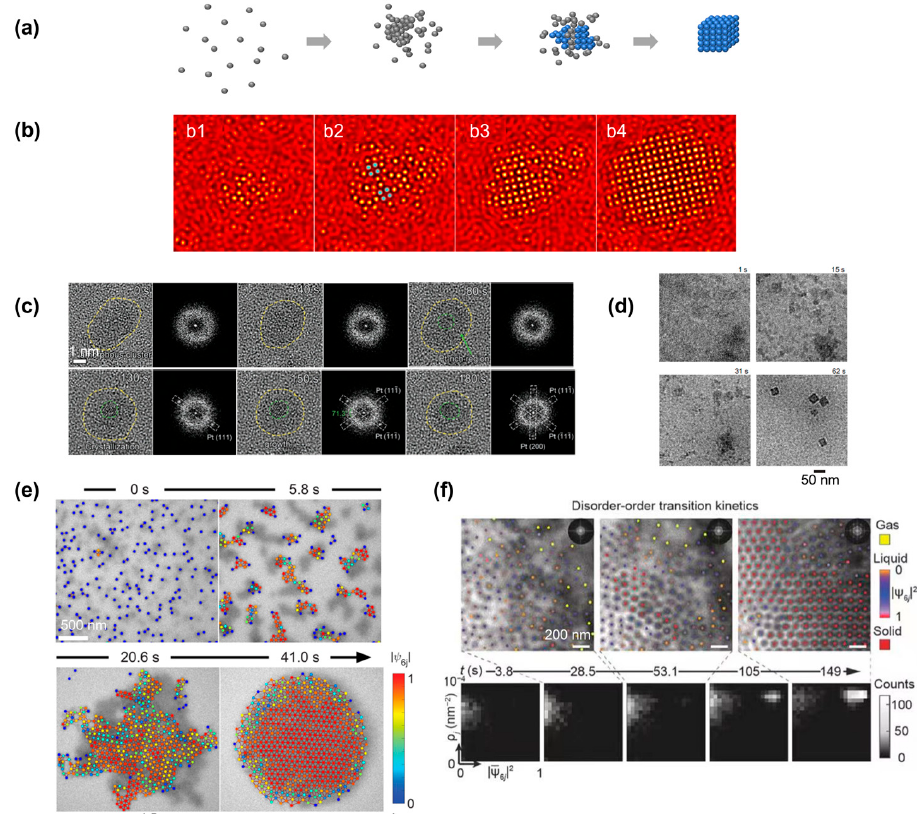
Figure 4. Simulation and experimental observations of the nonclassical crystallization pathway in which the crystalline domain nucleated from a large amorphous precursor: ( a ) Schematics illustrating the nonclassical crystallization pathway and highlighting the formation of an amorphous precursor first, from which the crystalline domain nucleated. ( b ) Simulation snapshots illustrating the formation of a large amorphous precursor first, and the crystalline domain (highlighted in blue) nucleated from inside of the cluster. From ( b1 ) to ( b4 ), the temporal evolution of a single nucleus is shown in computer simulation. Reproduced with permission from Ref. [35]. Copyright 2016 American Chemical Society. ( c ) Liquid-phase TEM observations of the structural evolution of a large amorphous cluster of Pt and the transformation to a crystalline structure. Fast Fourier transformations are also included to highlight the structure transition. Reproduced with permission from Ref. [65]. Copyright 2022 Wiley Materials. ( d ) Liquid-phase TEM images showing the crystallization process of a ZIF-8 metal–organic framework nanocube from solution. Reproduced with permission from Ref. [33]. Copyright 2021 National Academy of Science. ( e ) Liquid-phase TEM images showing the two-step crystallization of gold nanospheres. Reproduced with permission from Ref. [70]. Copyright 2022 American Chemical Society. ( f ) Time-lapse liquid-phase TEM images showing the real-time crystallization process of a high concentration of triangular-shaped gold nanoparticles. The density structure histograms at the bottom highlight the formation of an amorphous structure first before the transition to the final crystalline lattice. Corresponding order density histograms. Reproduced with permission from Ref. [49]. Copyright 2019 Springer Nature.